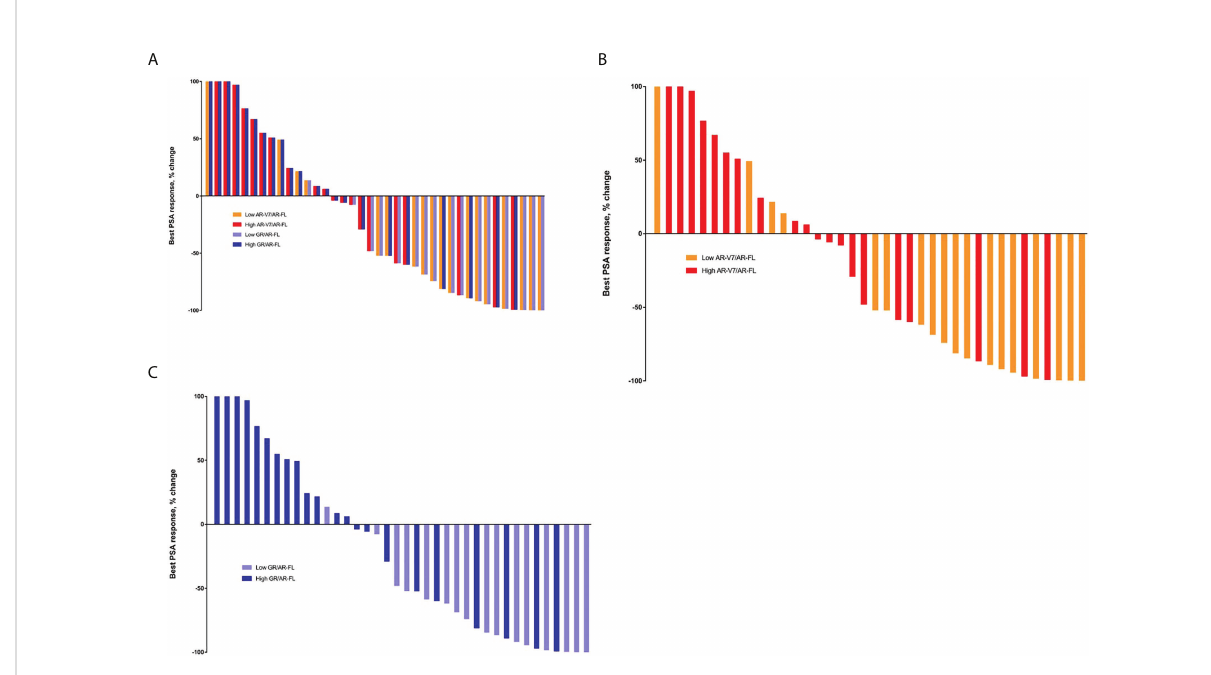
FIGURE 1 Best PSA responses in patients treated with AR-targeting therapy. (A) Waterfall plot based on both AR-V7/AR-FL and GR/AR-FL ratios. (B) Waterfall plot based on AR-V7/AR-FL ratios. (C) Waterfall plot based on GR/AR-FL